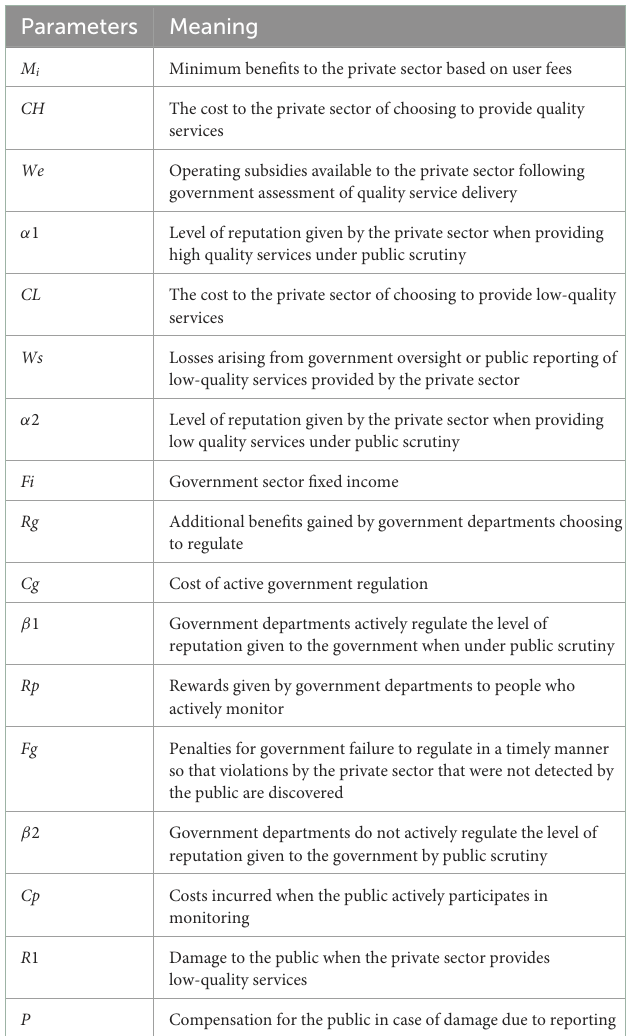
TABLE 1 Parameters and meaning of game